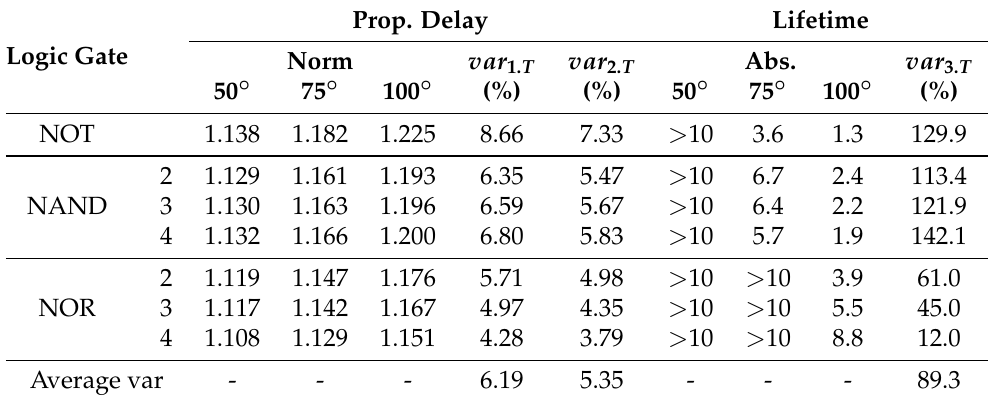
Table 5. Temperature-induced variability in propagation delay and LT.